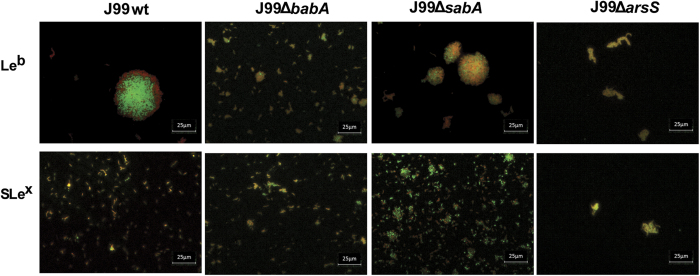
Images of aggregates formed after culturing J99 wt and its isogenic arsS, babA and sabA deletion mutants with glycoconjugates.Live (green color) and dead (red color) J99 wt, J99ΔarsS, J99ΔbabA and J99ΔsabA after 24 h culture with Leb- and SLex-glycoconjugates and stained with the LIVE/DEAD BacLight bacterial viability kit. The images are representative of the whole sample, and of three experiments.